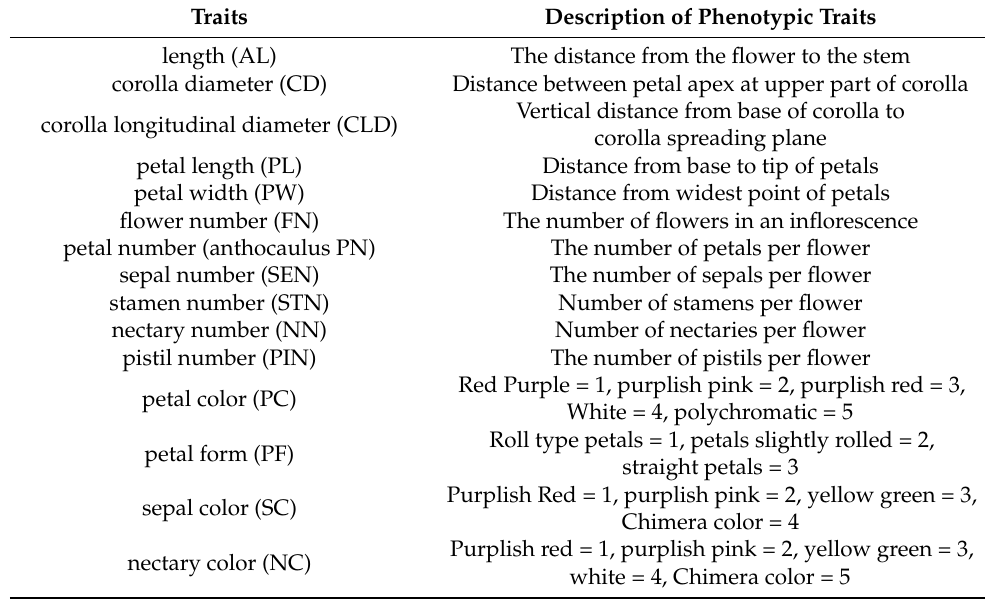
Table 1. Morphological diversity indexes and description of L. chinense var. rubrum .